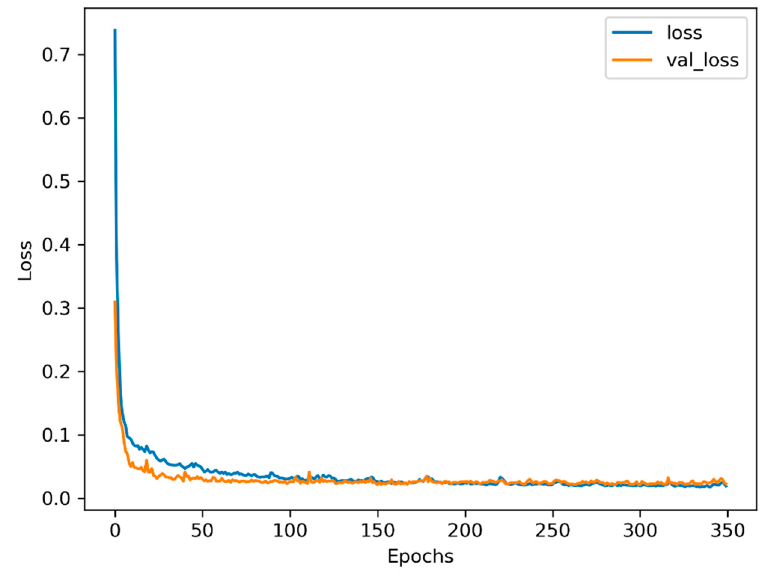
Figure 10. Training and validation loss with 64 hidden units and four time steps.